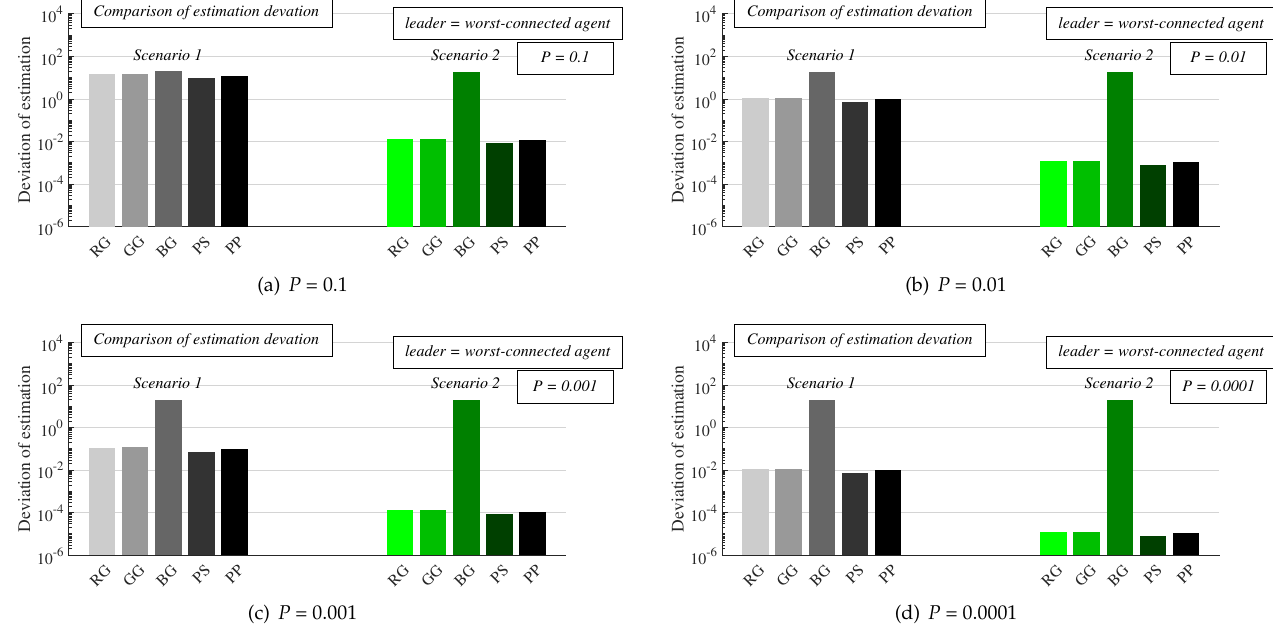
Figure 13. Comparison of the estimation precision of all algorithms in both scenarios for various configurations of implemented stopping criterion—worst-connected agent is